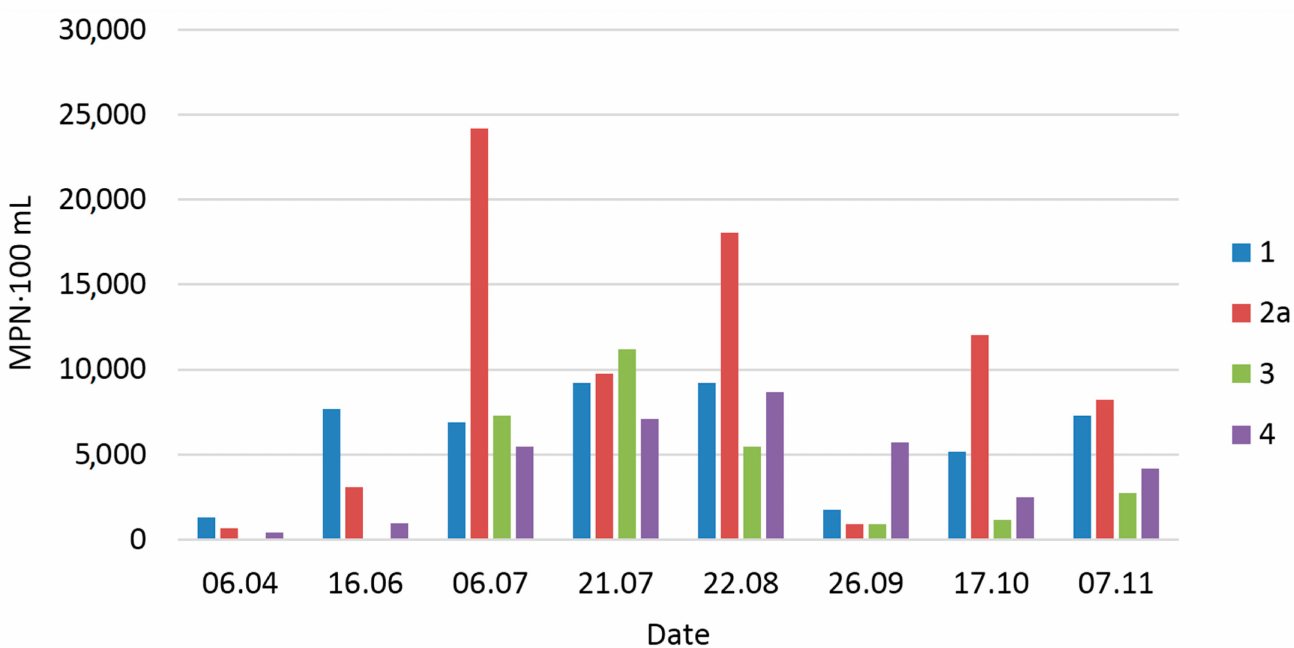
Figure 7. Variability of the number of coliform bacteria in the SED-BIO system in the test period April–November 2016. The results are shown as MPN (most probable number) in 100